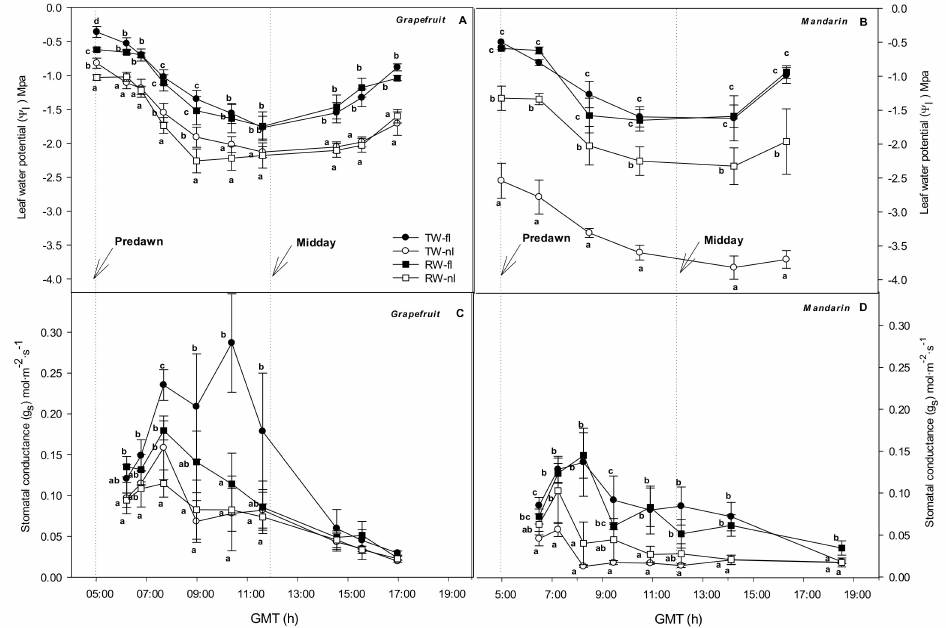
Figure 1. Daily evolution of leaf water potential ( Ψ l ) ( A , B ) and stomatal conductance (g s ) ( C , D ) for each treatment (TW-fI: transfer water—fully irrigated; TW-nI: transfer water—non-irrigated; RW-fI: reclaimed water—fully irrigated; RW-nI: reclaimed water—non-irrigated) and crop (grapefruit and mandarin). Each point is the average ± standard deviation of 4 blocks, collected at 248 DOY. Different letters indicate significant differences at p < 0.05, as assessed using Tukey’s